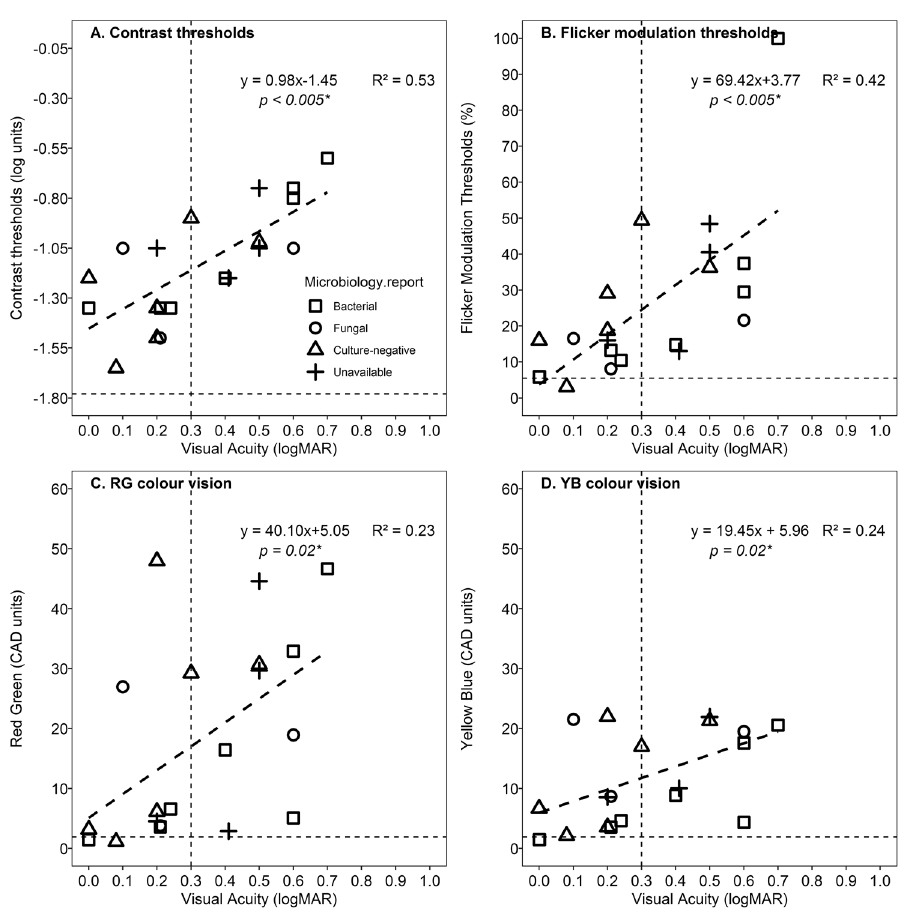
Figure 2. Scatter plots showing how each of the visual functions relates to visual acuity with the mapped microbiologic profile. ( A , B ) show spatial and temporal contrast thresholds against visual acuity. ( C , D ) show R-G and YB chromatic thresholds respectively plotted against VA. The black dashed lines show the regression line fitted by a linear function whose equation is provided in each of the panels. The horizontal grey dashed line in each of the panels indicates age-corrected normal values for the visual functions. The regression equation is provided in each of the panels along with coefficient of determination (R 2 ). The p value indicates of the slope is significantly different from zero. The vertical line indicates visual acuity cut-off of 20/40 (logMAR 0.30). The legend indicates the microbiological profile of these patients as well. Three data points have been horizontally shifted by 0.01 log unit to avoid overlapping of